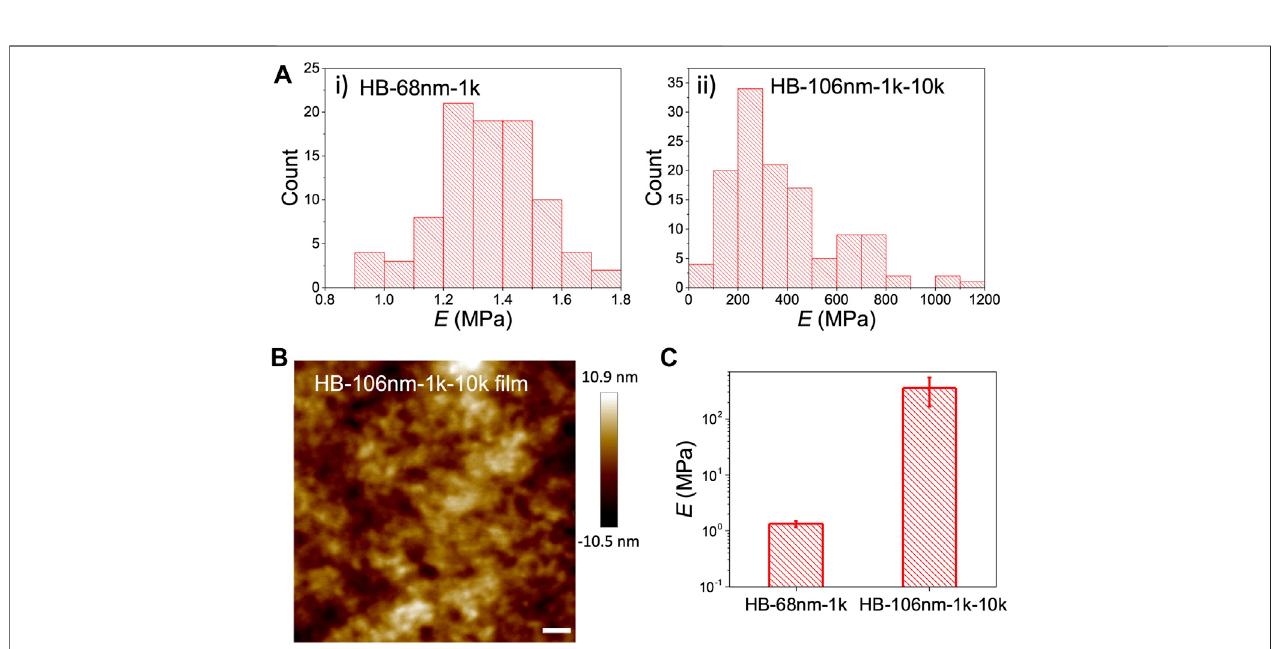
( Figure 3B ), demonstrating the signi fi cantly enhanced mechanical properties. No crystal domains are detected in the HB-106nm-1k-10k — at least by AFM — in contrast to the crystalline morphology of the linear L10k PEO samples ( Supplementary Figure S3 ). This observation is also con fi rmed by DSC, presented below. More importantly, the measured Young ’ s moduli of HB PEO polymers differ considerably, as shown in Figure 3C : the E of HB-106nm-1k- 10k is ∼ 358 MPa, which two orders of magnitude higher than that of HB-68nm-1k, and is comparable to that of linear PEO with high M n and crystallnity (Jee et al., 2013). Thus, the moduli measurements con fi rm that grafting L10k onto the outside of the HB PEO signi fi cantly improves the mechanical properties.